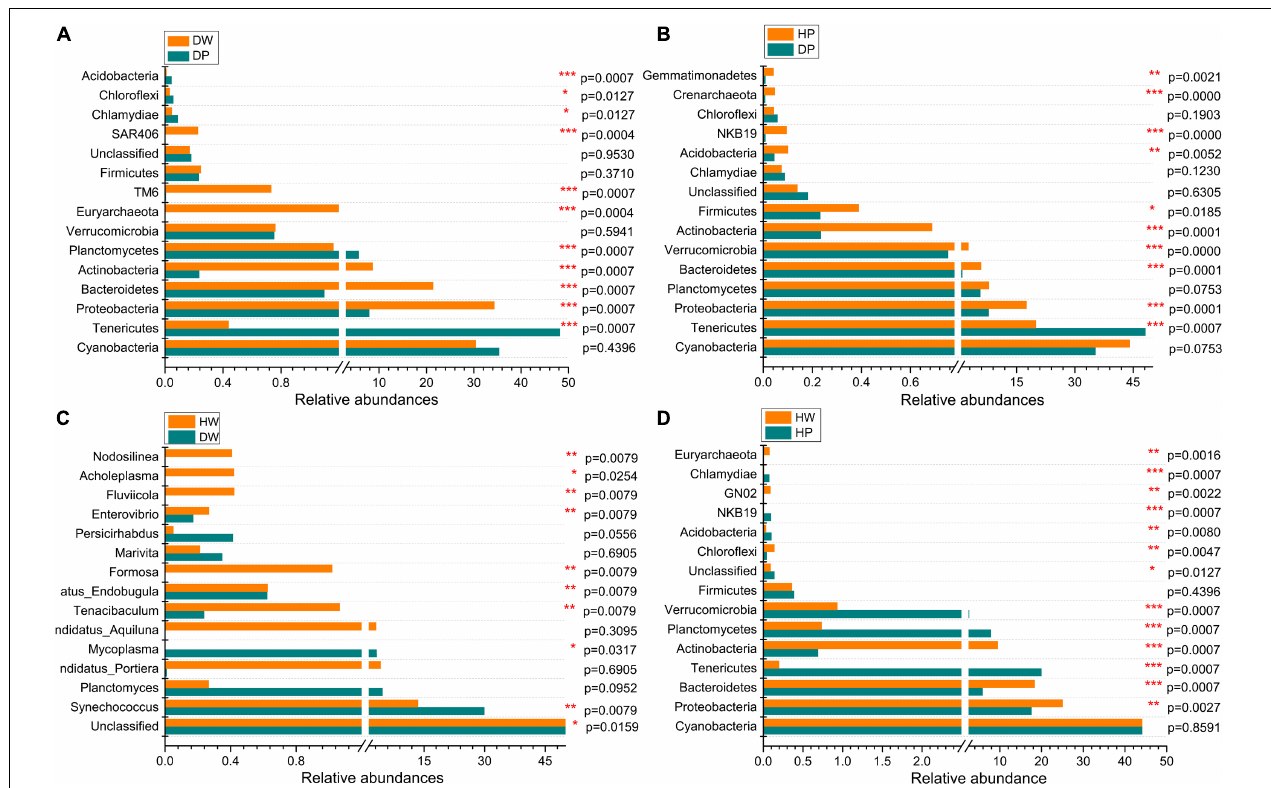
FIGURE 5 | Comparison of microbial community between DW and DP (A) , HP and DP (B) , HW and DW (C) , and HW and HP (D) at the phylum level. *0.01 < p ≤ 0.05, **0.001 < p ≤ 0.01, and *** p ≤